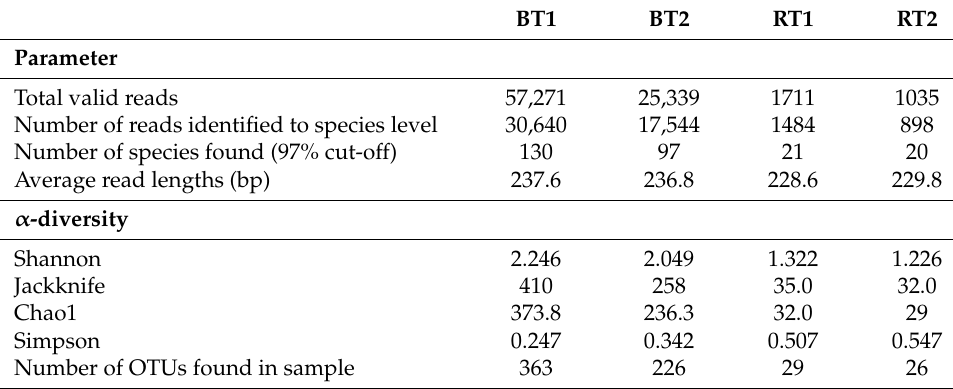
Figure 5. Comparative metagenomics of the actinobacterial populations of the refinery condensate tank (RT1 and RT2) and buffer tank (BT1 and BT2) grab samples. Only those with a relative abundance of >1% were included in this figure. Table 4. Comparision of the microbial population data for the buffer tank (BT1 and BT2) and refinery condensate tank (RT1 and RT2) grab samples.